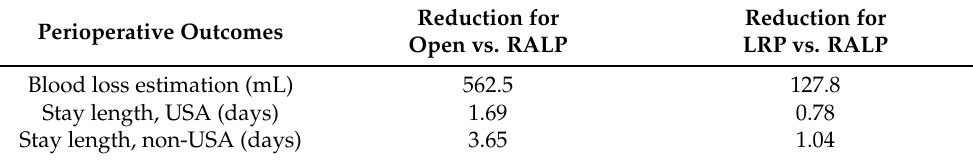
Table 1. Summarizing primary advantages of RALP versus, LRP and open. Reduction for Reduction for Perioperative Outcomes Open vs. RALP LRP vs. RALP Blood loss estimation (mL) 562.5 127.8 Stay length, USA (days) 1.69 Stay length, non-USA (days) 3.65